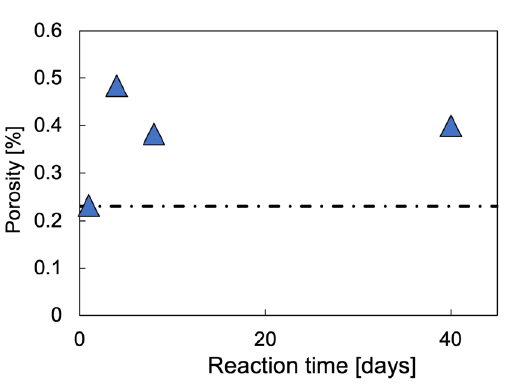
Figure 4. Porosity changes based on weight change during CAR dissolution experiments. Error bars are smaller than symbols. Streaked line indicated pristine CAR marble